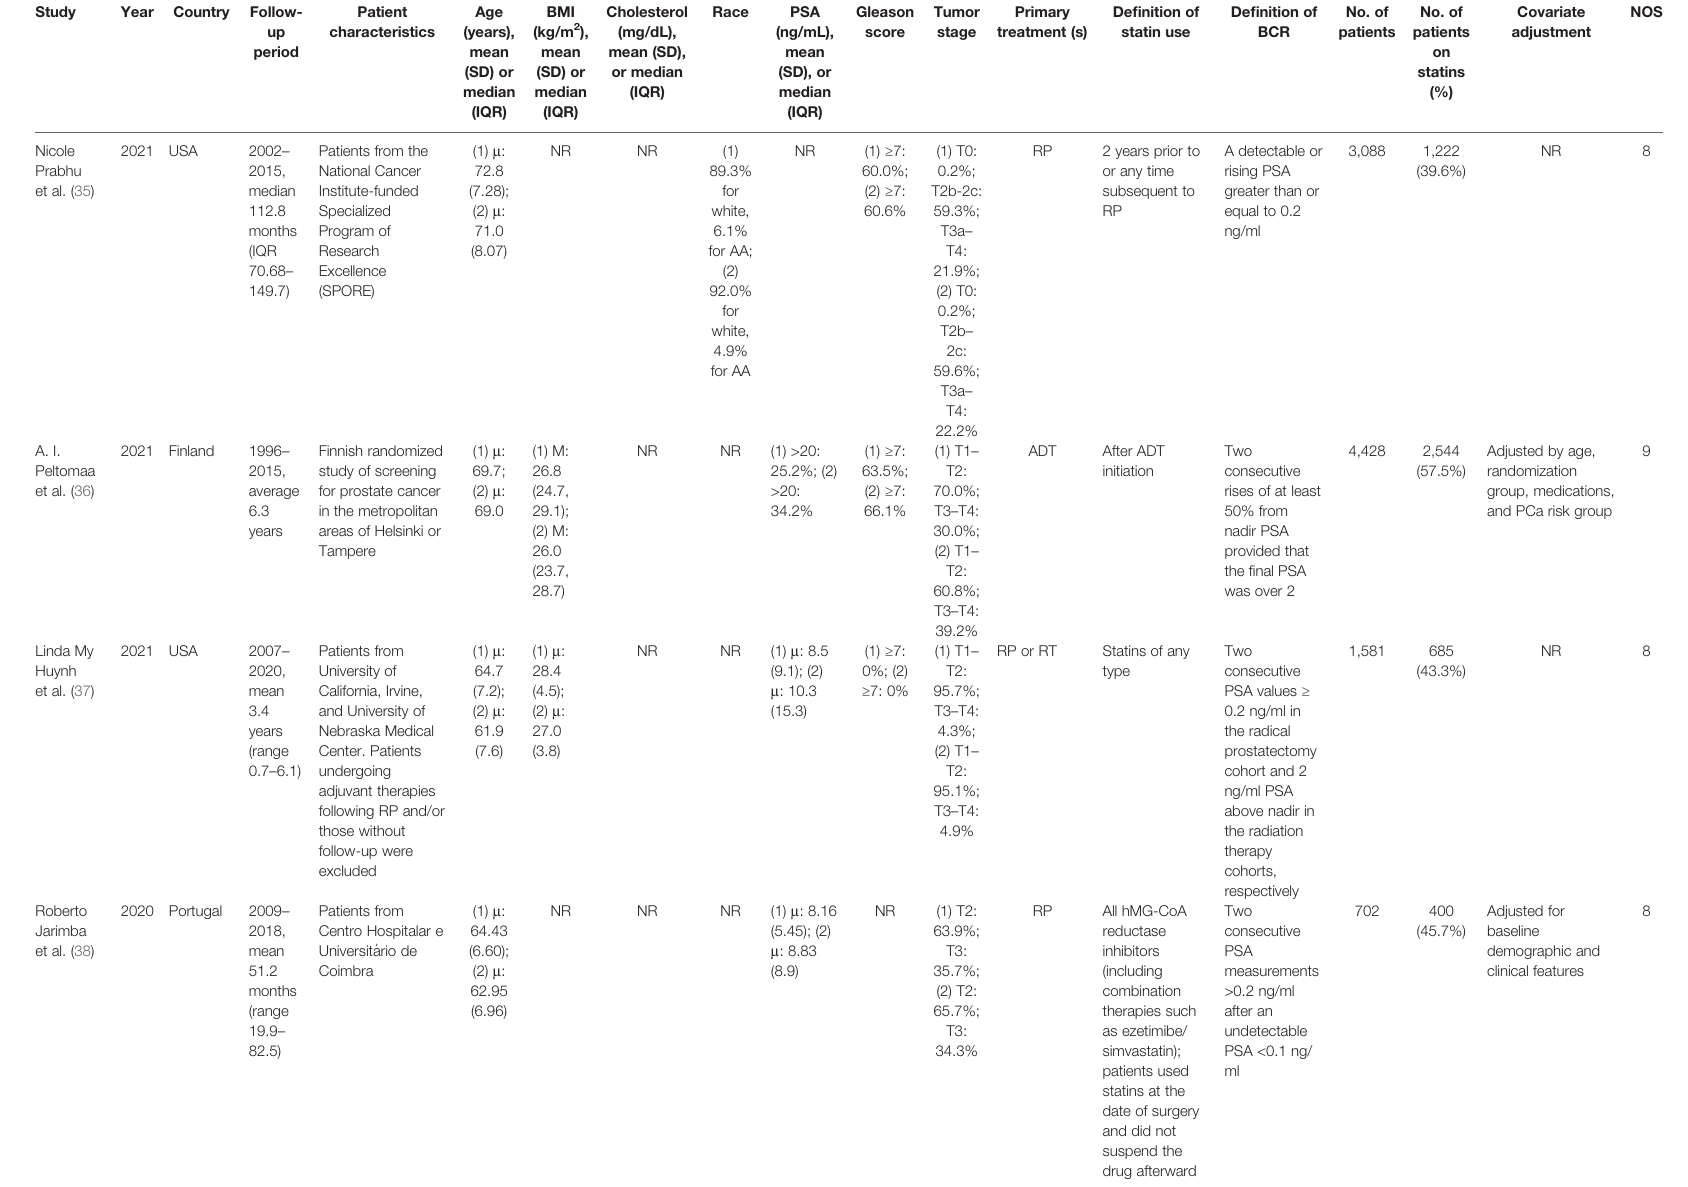
TABLE 1 | Characteristics of included studies in the systematic review and meta-analysis. Study Year Country Follow-